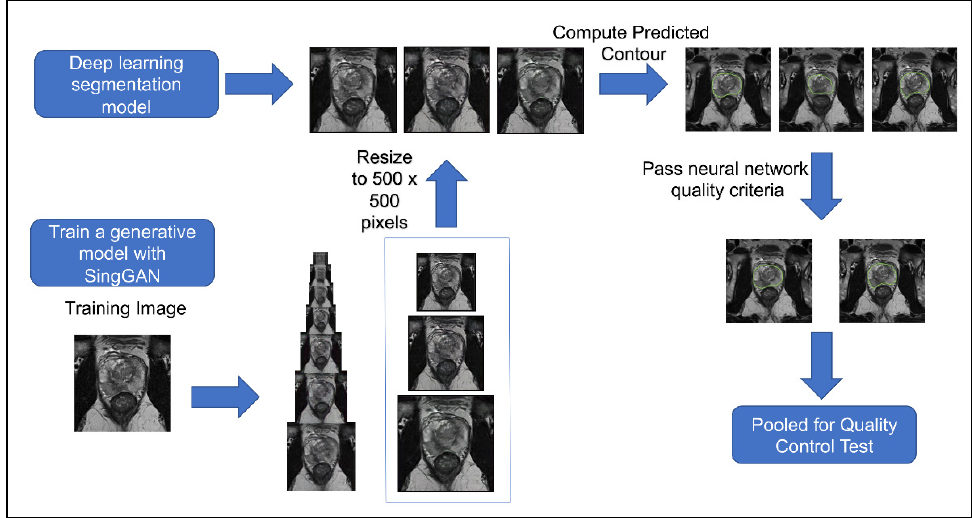
Figure 4. Workflow of procedure for second human quality control assessment. Three synthetic samples output by the last three generative models from SinGAN were resized to 500 × 500 and then given a predicted segment of the prostate using a pre-trained segmentation neural network. Synthetic images that had a segmentation of the contour that passed our defined criteria were pooled and randomly selected for our human visual assessment.